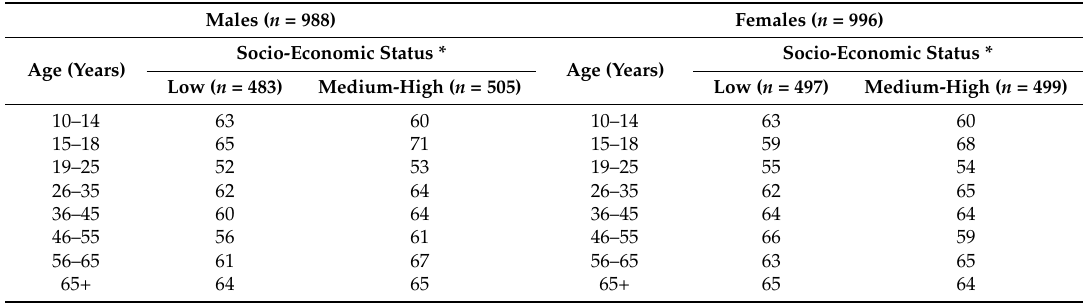
Table 1. Number of participants within each demographic category ( n =